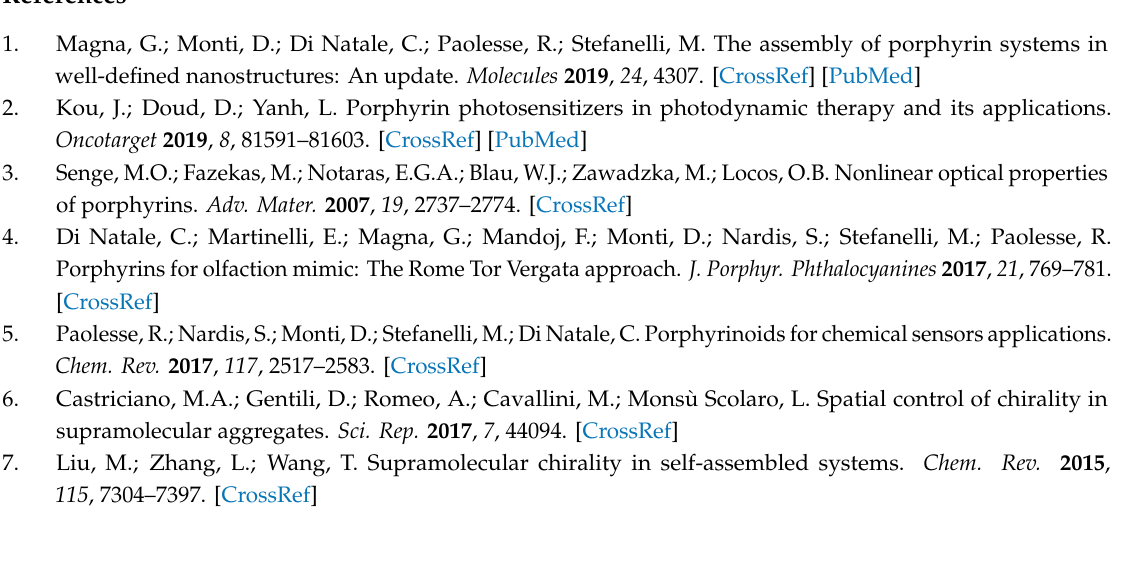
Scheme S1: Scheme of the synthesis of the compounds used in the work, Figure S1: CD spectra of equilibrium solutions of ( D )ZnP(-) and ( L )ZnP(-) in the presence of ( R )-1-phenyl-ethanamine and ( S )-1-phenyl-ethanamine, Figure S2: UV-Vis and CD spectra of the aggregates of ( D )ZnP(-) in the presence of achiral benzylamine, Figure S3: UV-Vis spectral variations with time of ( L )ZnP(-) in the presence of ( R )-1-phenyl-ethanamine, and corresponding kinetic plot, Figure S4: UV-Vis and CD spectral variations with time of ( L )ZnP(-) (10 µ M) in the presence of ( R )-1-phenyl-ethanamine (1.0 × 10 − 3 M), Figure S5: SEM topographies of precipitates from 10 µ M equilibrium solutions of ( D )ZnP(-) (A) and ( L )ZnP(-) (B) in the presence of ( S )-1-phenylethanamine, Figure S6: Microscope transmission and fluorescence emission images of drop casted equilibrium solution on glass of ( D )ZnP(-)@( R )-1-phenylethanamine